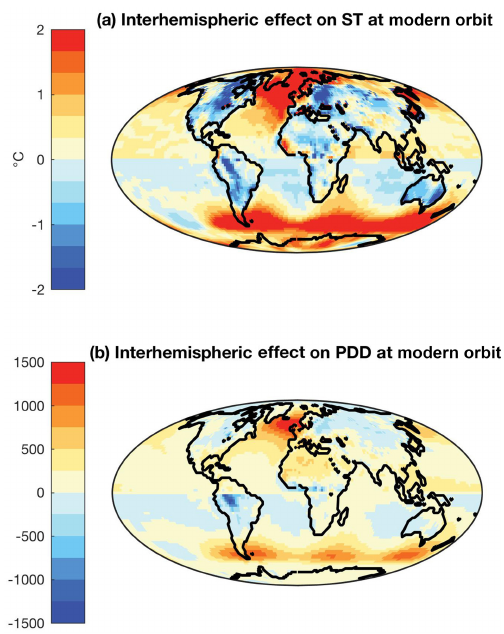
Figure 4. Interhemispheric effect of continental geography on (a) mean summer temperature (ST) and (b) positive degree days